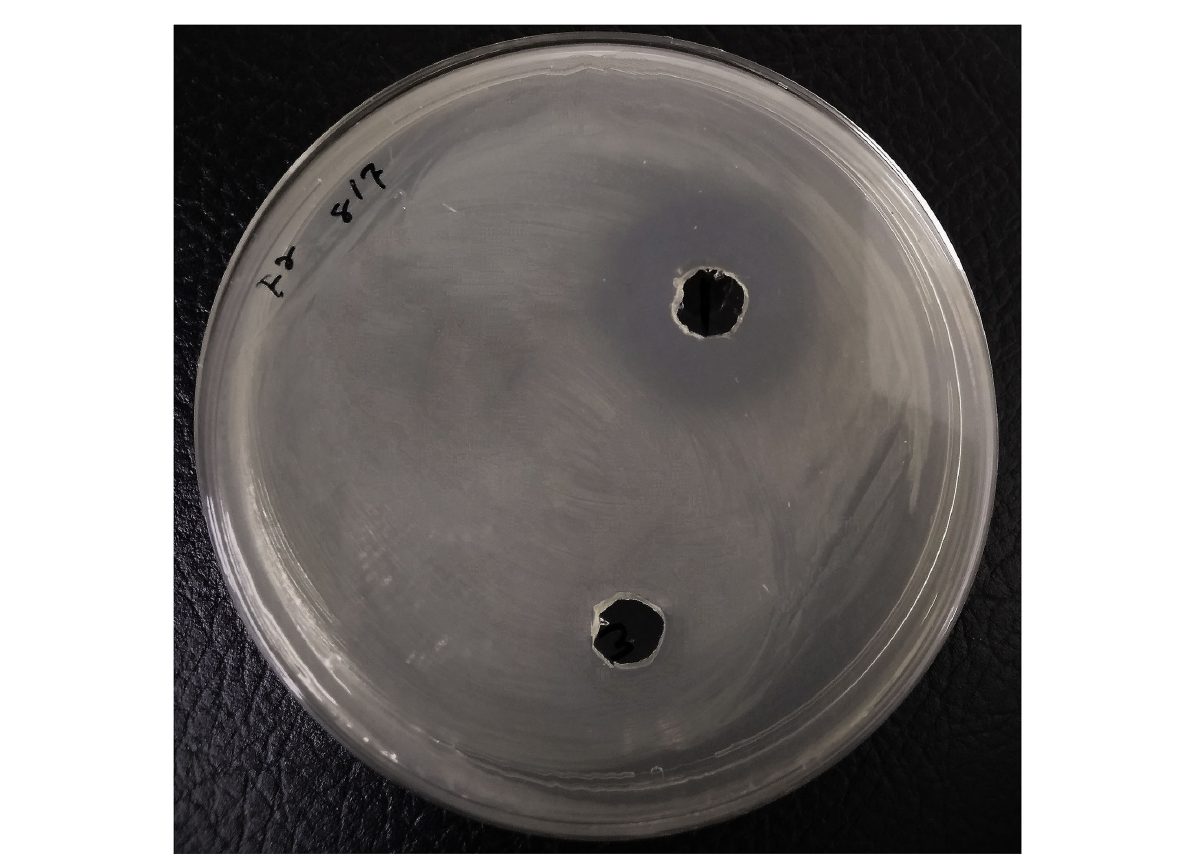
FIGURE11 Agar well diffusion assay using bacterial extracts loaded in the wells and Lelliottia amnigena RCE spread over the agar. Control has the same concentration of DMSO.